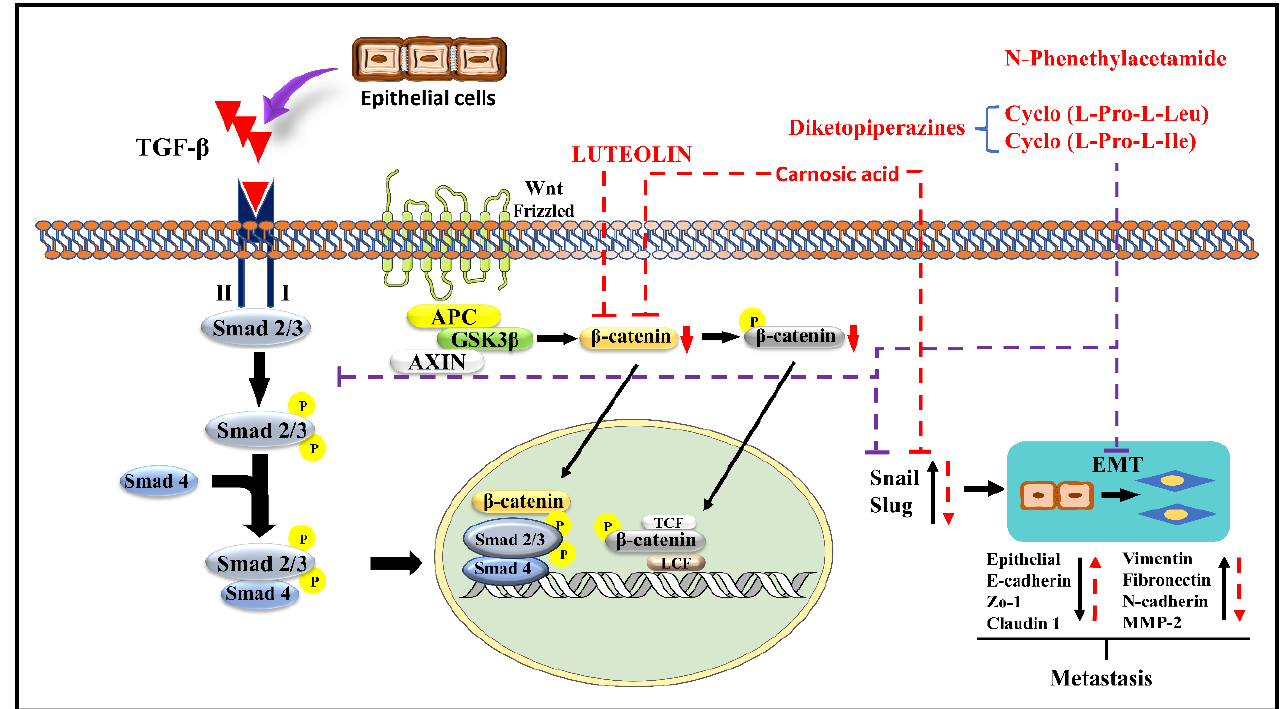
Figure 4. Possible mechanisms of luteolin, Carnosic acid, and N-Phenethylacetamide inhibit EMT via different pathways [94,95].